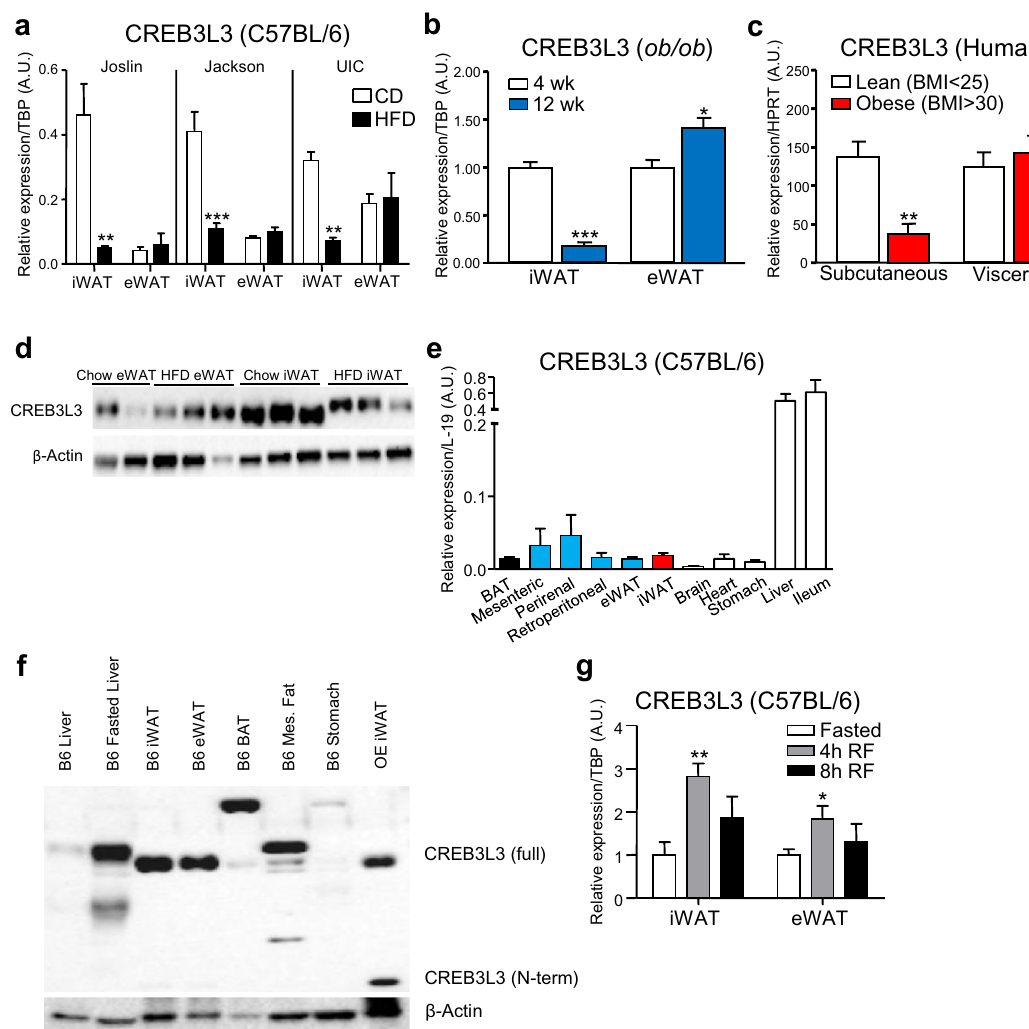
Figure 1. CREB3L3 is expressed in adipose tissue and selectively downregulated in obese subcutaneous fat. ( a , b ) Quantitative PCR for CREB3L3 message in inguinal (iWAT) and epididymal (eWAT) white adipose tissue from ( a ) C57BL/6 mice fed a high-fat diet for 12 weeks at the indicated animal facility (n = 6 mice per group) or ( b ) ob/ob mice before (4 week) and after (12 week) developing obesity (n = 6 mice per group). CREB3L3 expression was normalized to TBP housekeeping gene and presented as ( a ) relative expression or ( b ) fold change over lean controls. ( c ) Quantitative PCR for CREB3L3 message in subcutaneous abdominal and omental fat from patients with a BMI ≤ 25 kg/m 2 (lean, n = 69) and BMI > 30 kg/m 2 (obese, n = 504). CREB3L3 expression was normalized to HPRT housekeeping gene. ( d ) Western blot measuring abundance of CREB3L3 in iWAT and eWAT from adult C57BL/6 mice fed chow or high-fat (HFD) diet for 12 weeks. ( e ) Quantitative PCR for CREB3L3 message in various tissues from lean C57BL/6 mice (n = 3 mice). CREB3L3 expression was normalized to L-19 housekeeping gene. ( f ) Western blot measuring abundance of CREB3L3 in various tissues from same lean C57BL/6 mouse, fasted C57BL/6 liver, or iWAT with overexpression of CREB3L3. ( g ) Quantitative PCR for CREB3L3 message in iWAT and eWAT from adult C57BL/6 mice that were fasted for 24 h or subsequently refed (RF) for 4 or 8 h (n = 4–5 mice per group). CREB3L3 expression was normalized to TBP housekeeping gene and presented as fold change over fasting group. Data are presented as mean ± SEM with sample sizes listed above. The difference in means was analyzed using Student’s t-test where *P < 0.05, **P < 0.01, and ***P <